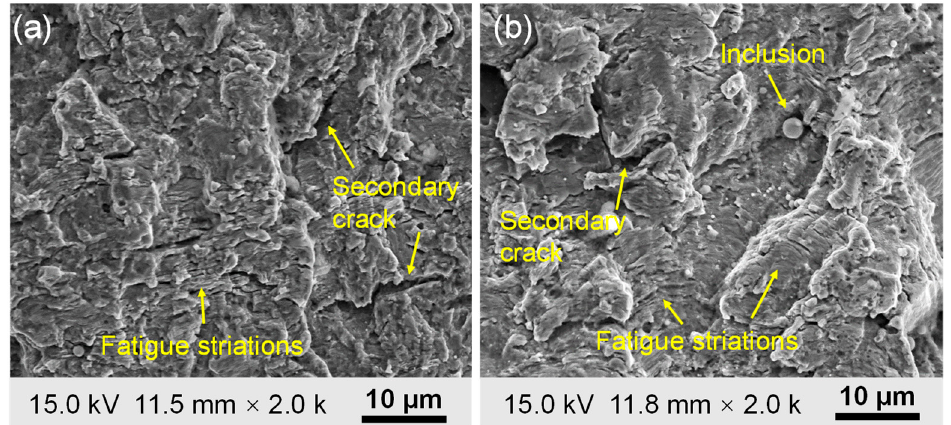
Figure 12. Typical fatigue-fracture surface morphology observed at the crack length of ( a ) 5.1 mm ( Δ K = 22.94 MPa·m 1/2 , / da dN = 6.96·10 − 5 mm/cycle) and ( b ) 16.6 mm ( Δ K = 40.25 MPa·m 1/2 , ( ∆ K = 22.94 MPa · m 1/2 , da / dN = 6.96 · 10 − 5 mm/cycle) and ( b ) 16.6 mm ( ∆ K = 40.25 MPa · m 1/2 , / da dN = 2.78·10 − 4 mm/cycle). The direction of fatigue crack propagation is from bottom to top. da / dN = 2.78 · 10 − 4 mm/cycle). The direction of fatigue crack propagation is from bottom to